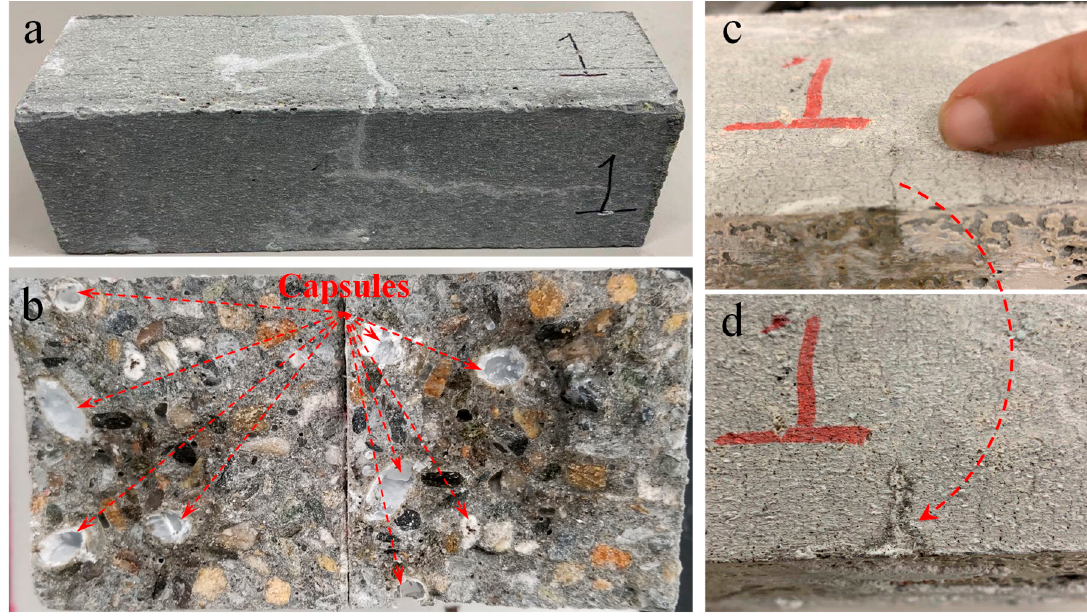
Figure 15. Morphology of ( a ) concrete beam surface, ( b ) fracture surface after bending, ( c ) and ( d ) crack